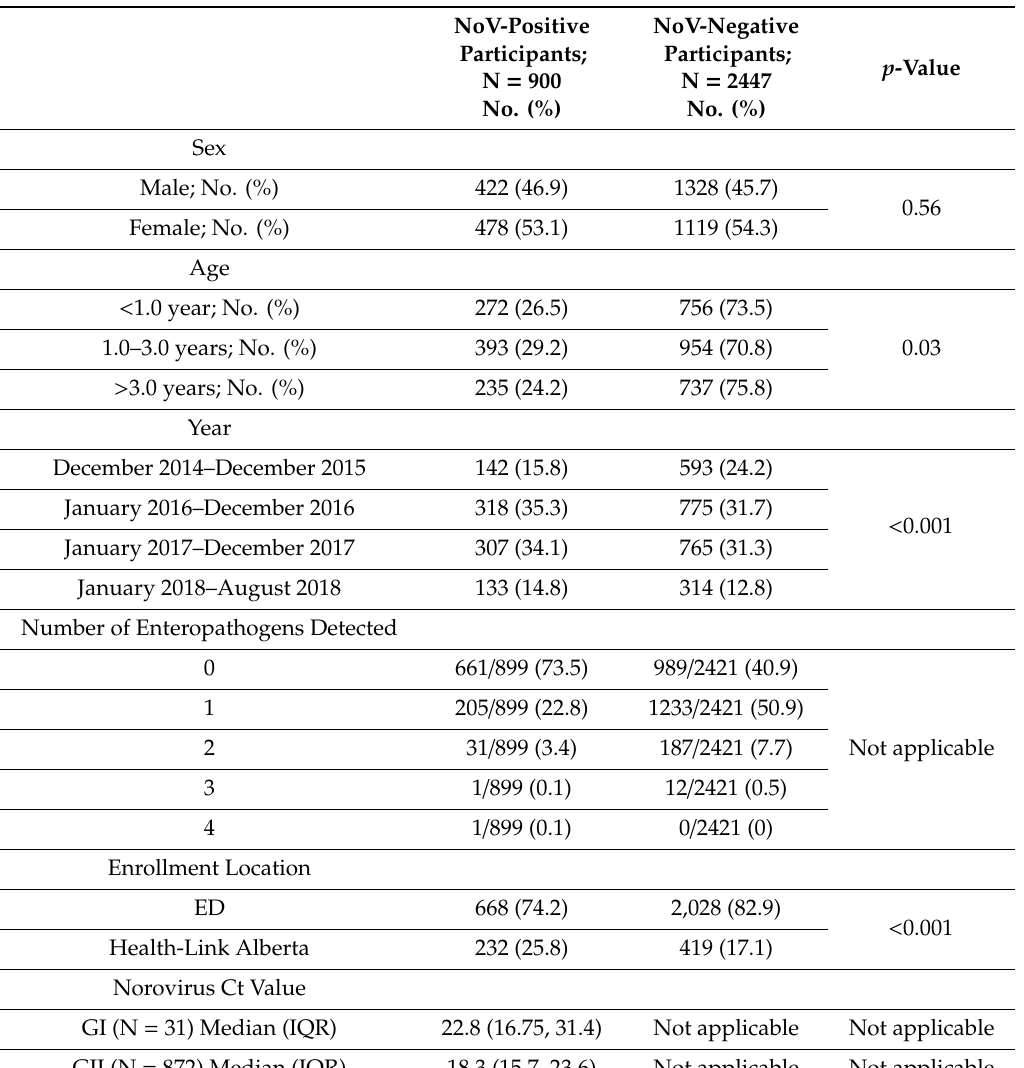
Table 1. Demographic characteristics, enteropathogen codetection, and norovirus threshold cycle values of the study